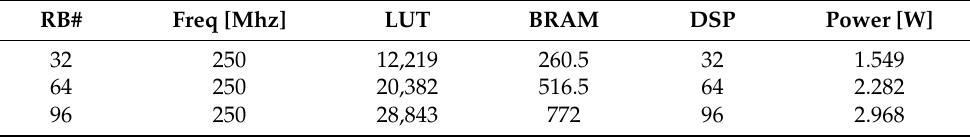
Table 6. RMLC FPGA implementation results.